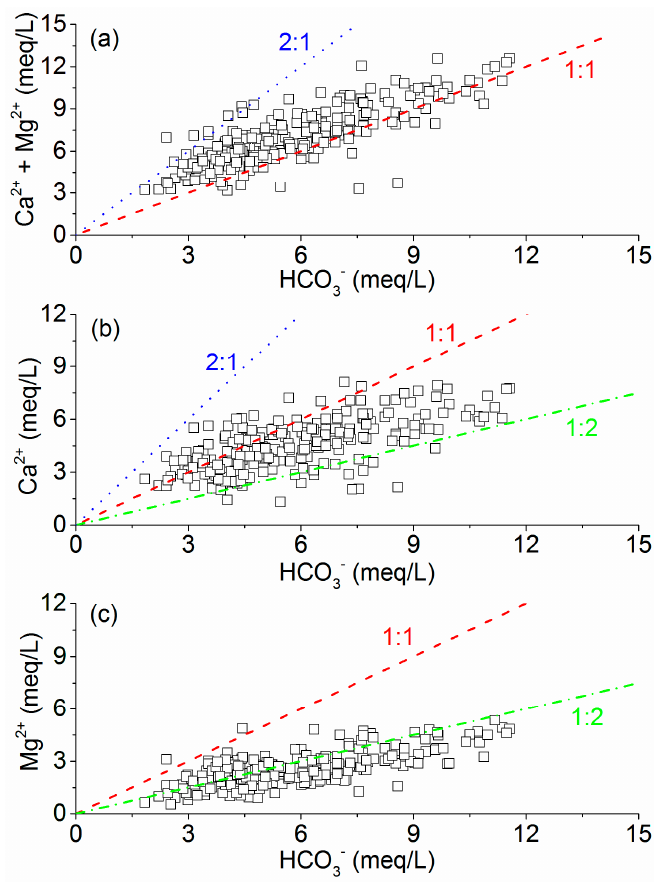
Figure 4. Bivariate diagrams of carbonate weathering and dissolution ( a ), calcite and dolomite weathering and dissolution ( b , c ).